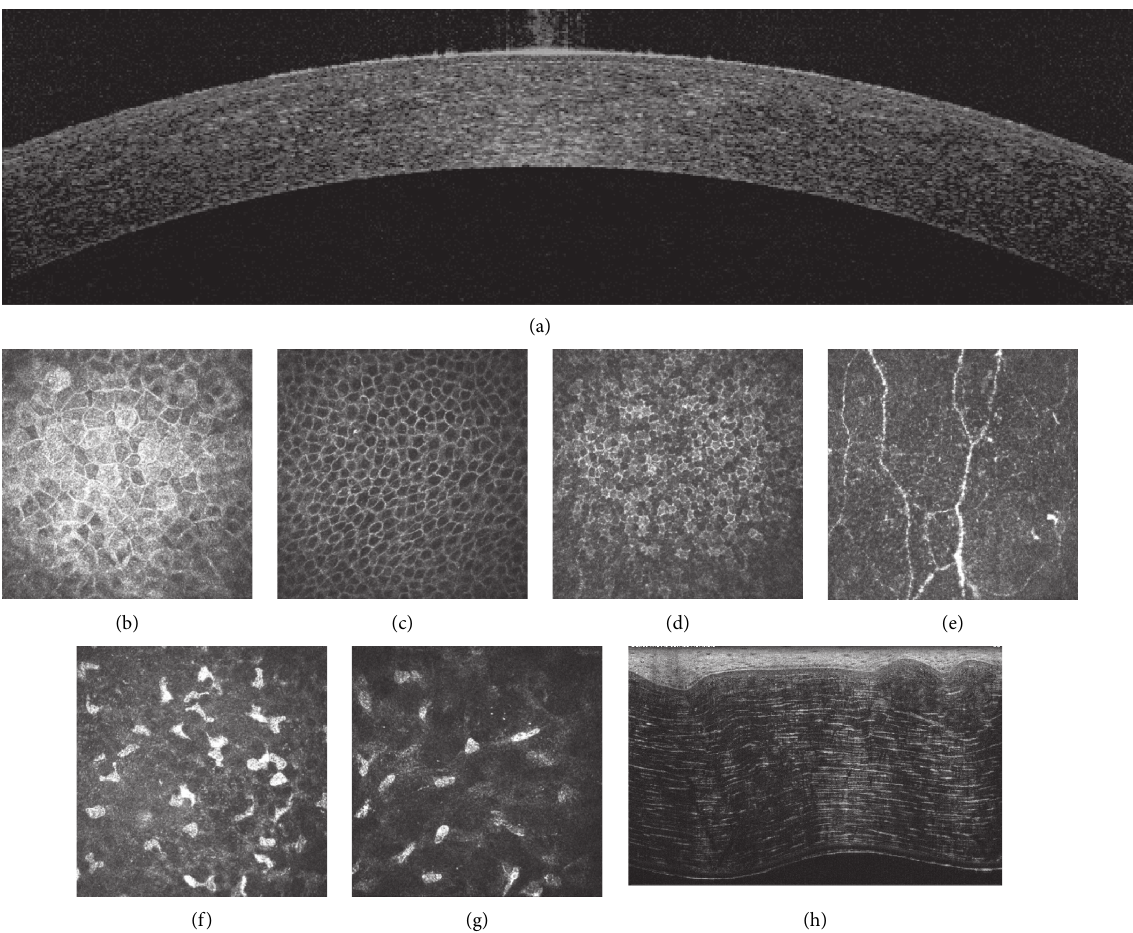
Figure 6: Spectral domain-optical coherence tomography (a), in vivo confocal microscopy (b–g), and ex vivo full-field optical coherence tomography of normal human corneas. A: cross-sectional SD-OCT scan. B: superficial epithelial cell layer. C: intermediate epithelial cell layer (wing cells). D: basal epithelial cell layer. E: subbasal nerve plexus. F: anterior stroma. G: posterior stroma. H: cross-sectional FF-OCT scan. No indicators of Schnyder dystrophy are